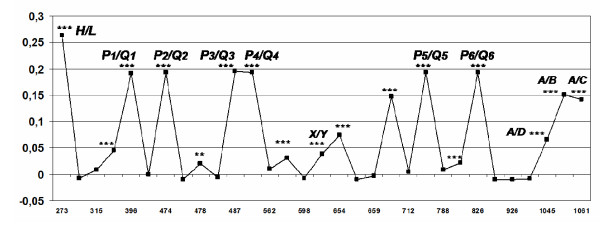
Global Fst values distributed along the sequence. Fsts were calculated using the data of Table 2 and of [19]. Nucleotide positions corresponding to variant sites are shown on the x-axis. *** p < 0.001, ** p < 0.01.